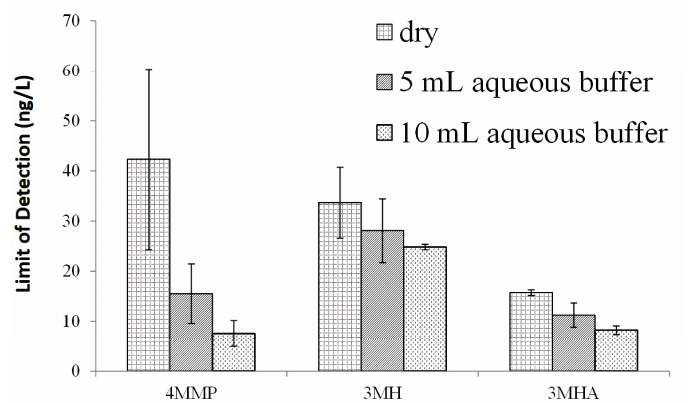
Figure 3. Detection limits for thiols obtained for dry vials or for vials reconstituted with 5 or 10 mL of aqueous buffer. Error bars represent ± 1 standard deviation for two replicates.